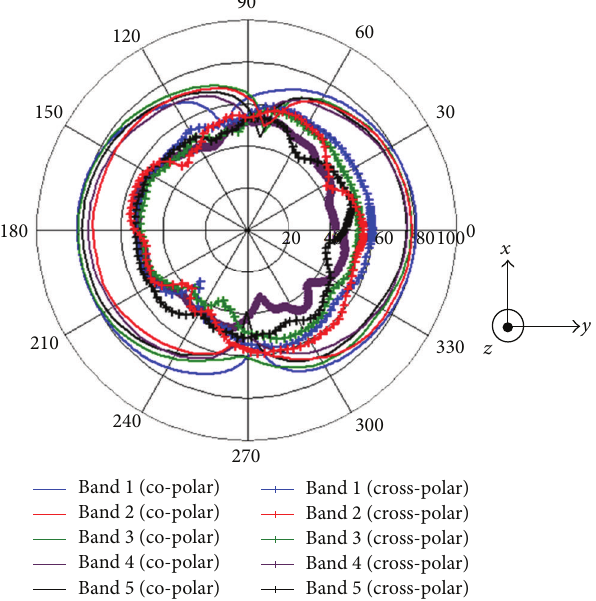
Figure 6: Measured E-plane radiation patterns (co-polar & cross- polar) at operating frequency, 𝑓 , for TMFDB25 with stubs 1, 2 at bands 1 to 5.